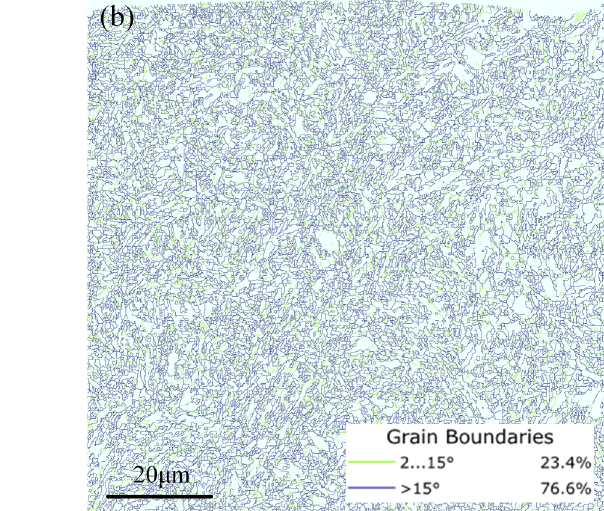
Figure 8. Grain boundary angle calculations: ( a ) surface layer of normal gear; ( b ) surface layer of tempered grinding burned gear.